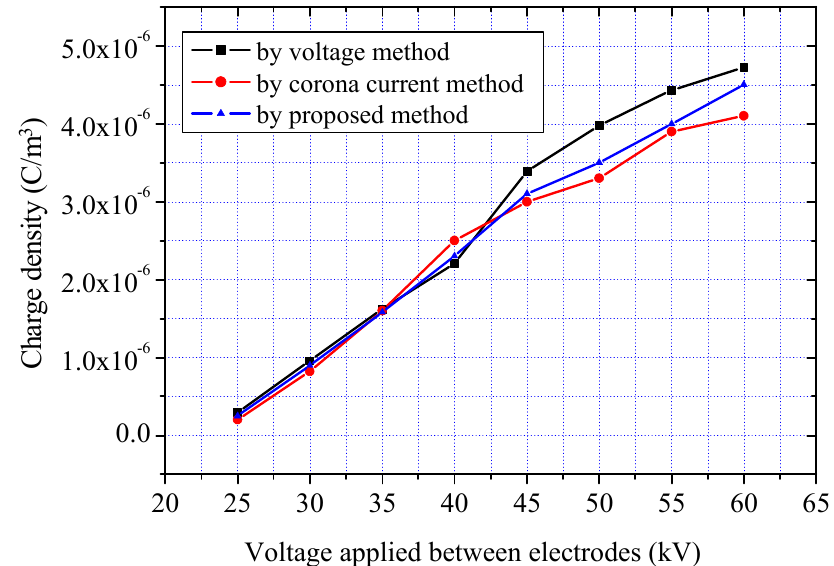
Figure 6 . Comparison of the space charge densities measured with three